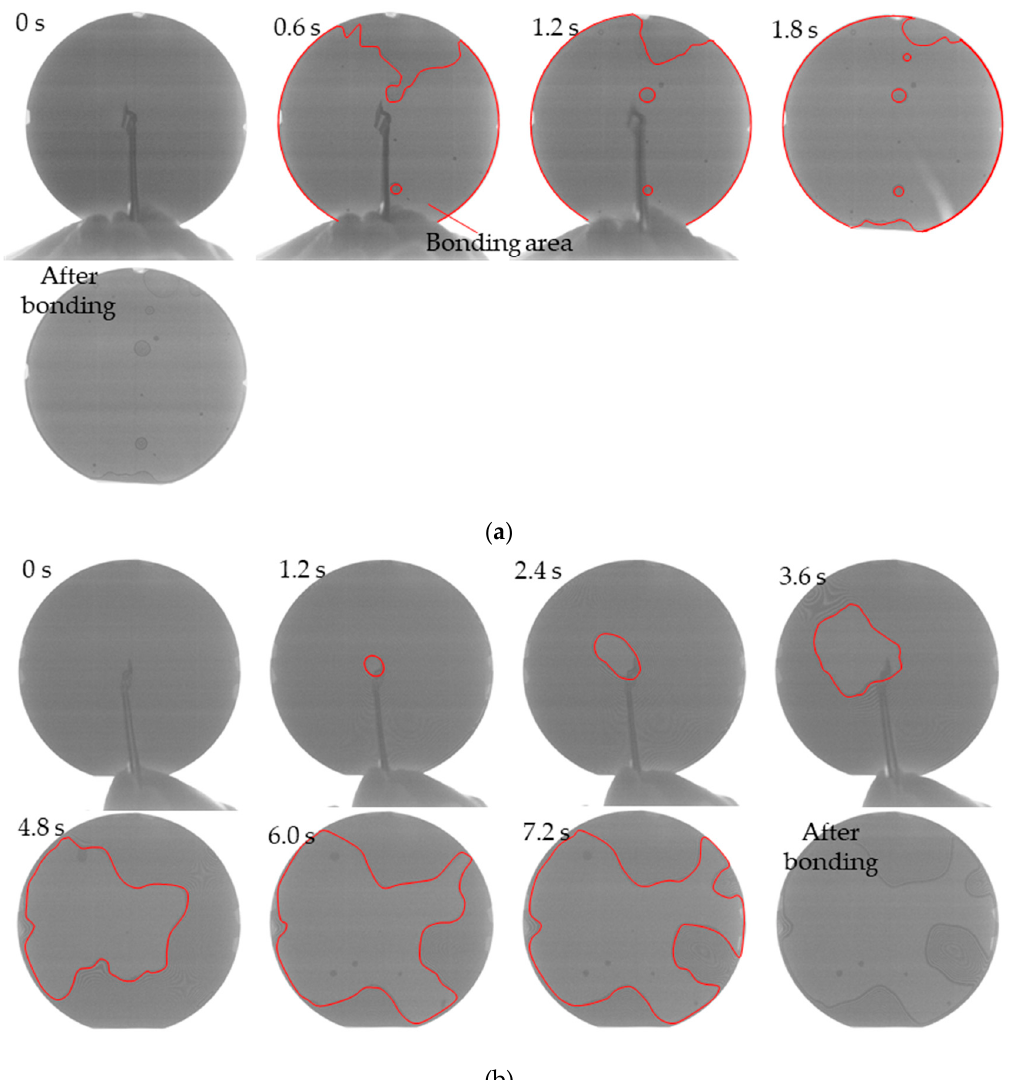
Figure 8. Images of increasing bonding area: ( a ) with 60 s Ar plasma treatment; ( b ) with 60 s O 2 plasma treatment. Table 1. Results of room-temperature wafer-scale Au–Au bonding with Ar or O 2 plasma treatment.